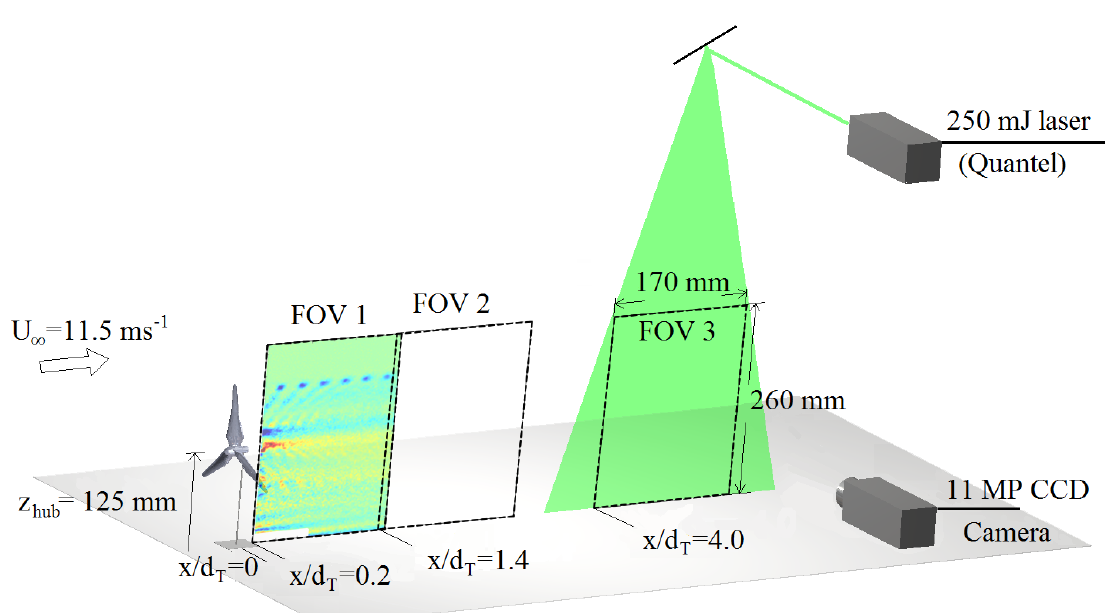
Figure 2. Schematic of the experimental setup for the standard and wingletted wind turbines including the three